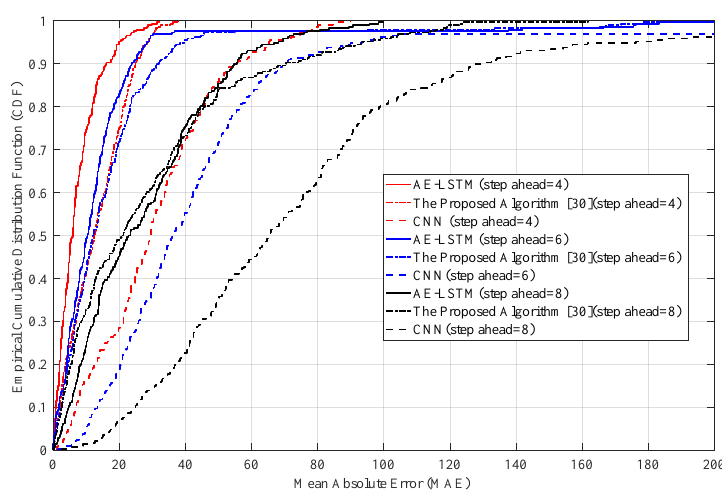
Figure 7. The cumulative distribution of MAE with different step-ahead.